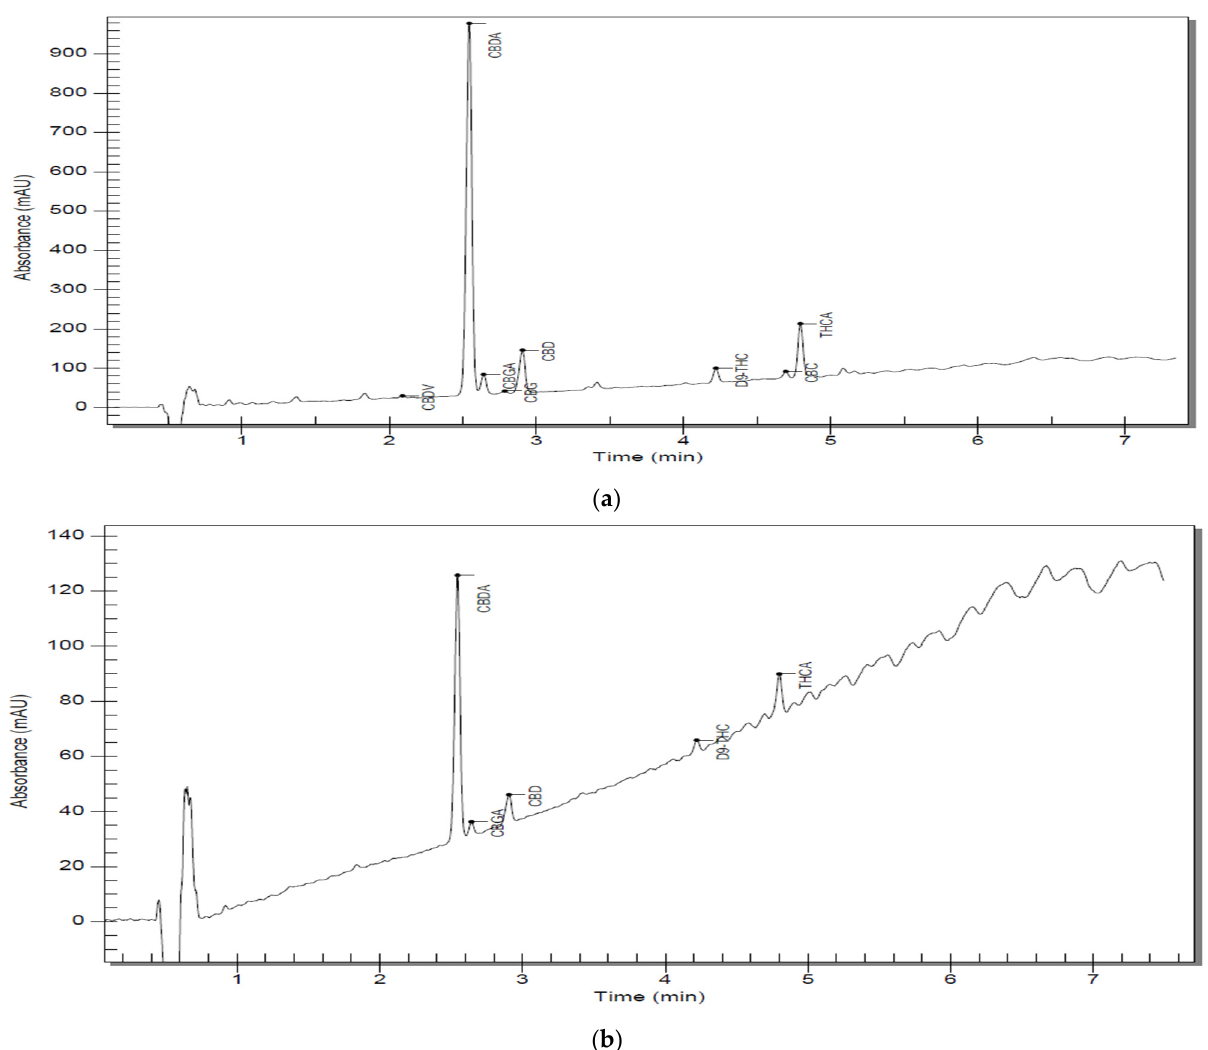
Figure 2. ( a ) Chromatographic trace of S5 D300 analyzed by RP–HPLC–PDA; ( b ) chromatographic trace of an S5 D3000 analyzed by RP–HPLC–PD.